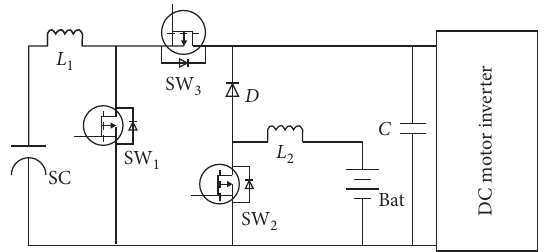
Figure 1: Topology of the variable structure HESS.